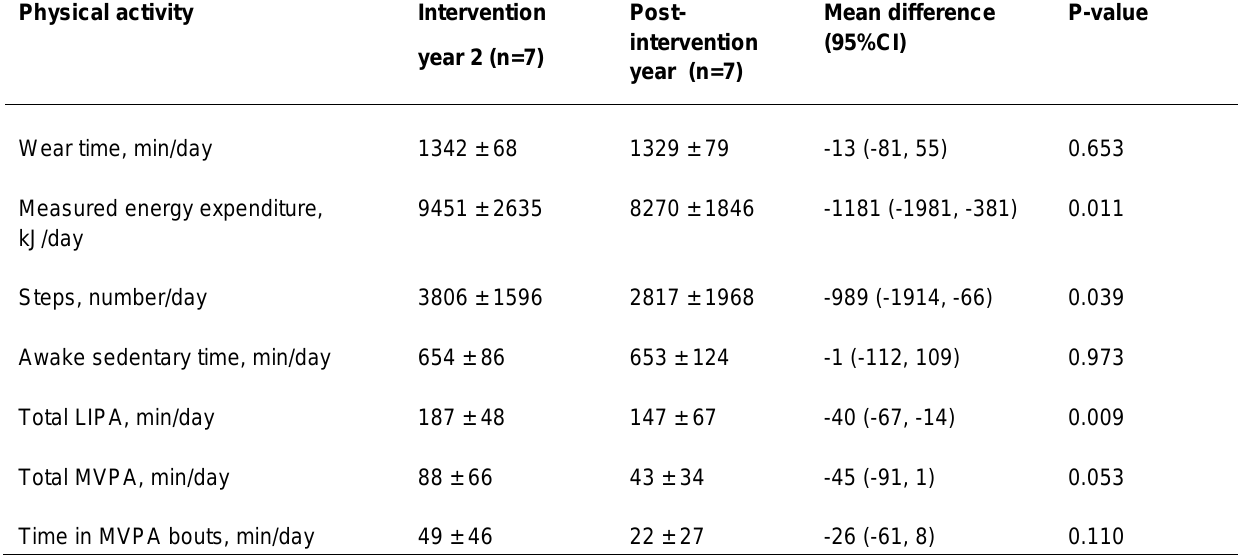
Table 3. Physical Activity (Second Year of the Telerehabilitation vs. Post-intervention